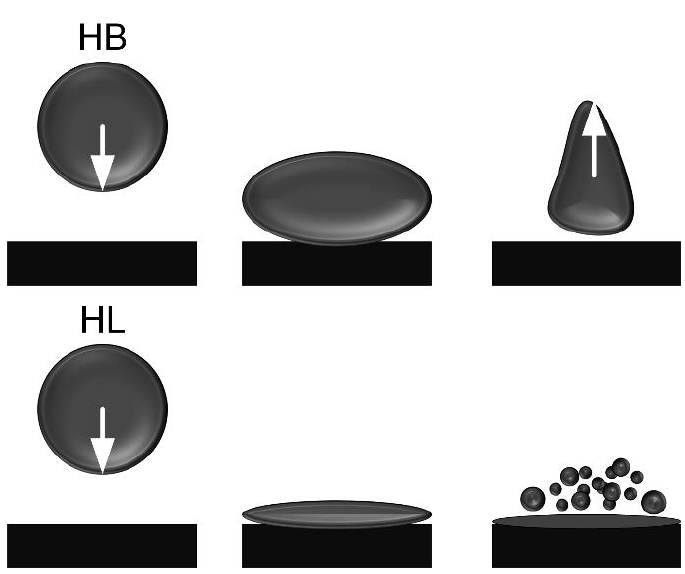
Figure 6. Droplet impingement on a surface: HB stands for hydrophobic surface; HL is hydrophilic surface.